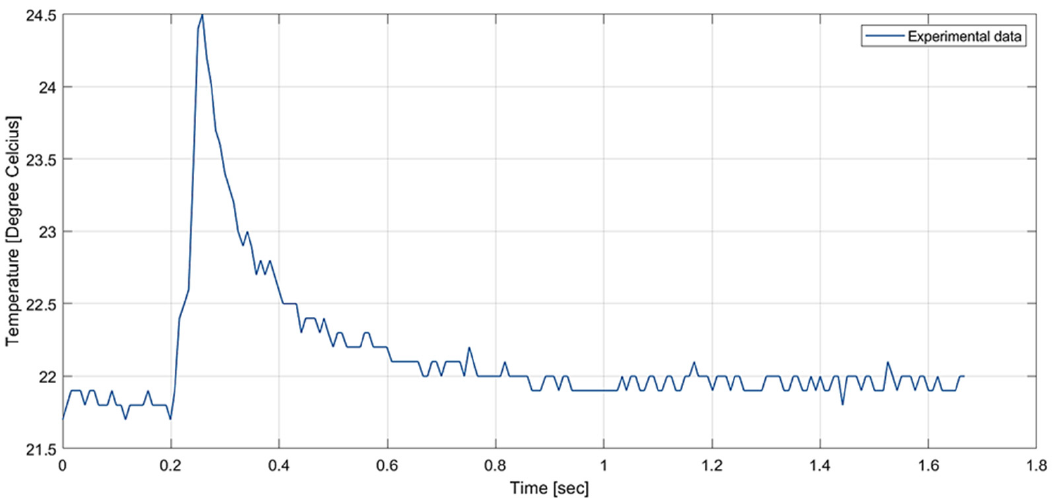
Figure 9. The temperature vs. time plot of the DWIT captured using thermography.